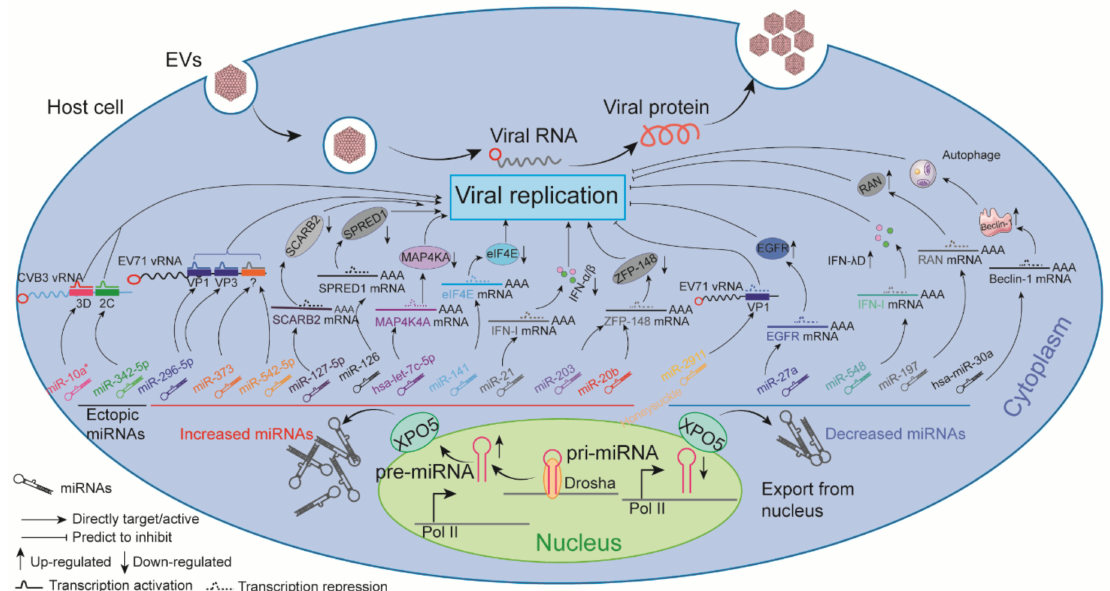
Figure 1. The impact of ncRNAs on EV replication. Dysregulated ncRNAs directly target the viral genome or indirectly bind to type I interferon (IFN) genes, protein-coding genes, functional molecules, and corresponding receptors to affect virus